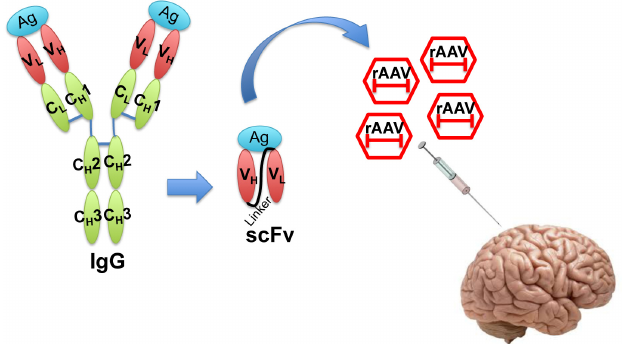
Figure 2. Illustration of single-chain fragment variable (scFv) structure and recombinant adeno-associated virus (rAAV) delivery of scFv. Engineered scFv lacking the constant regions of IgG is a much smaller molecule that still retains the antigen binding